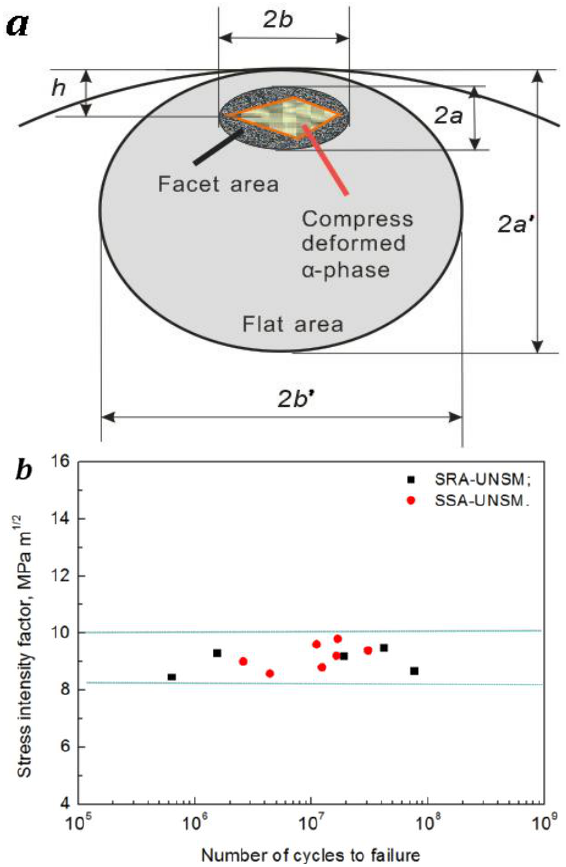
Figure 10. Stress intensity factor of TC4 with UNSM: ( a ) Schematic illustration of a fish-eye type fracture after UNSM; ( b ) Relationship between fatigue life and stress intensity